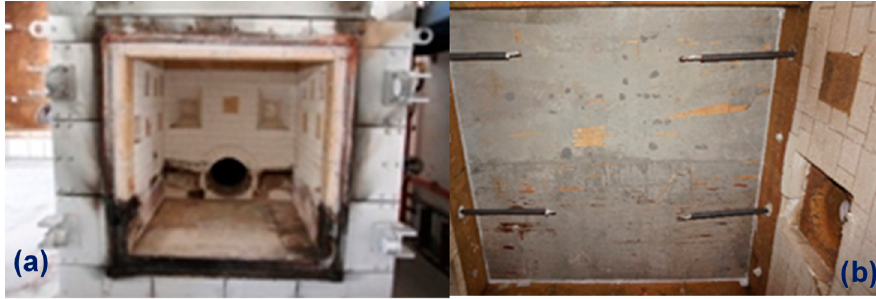
Figure 4. Fresh concrete test results ( a ) slump-flow ( b ) V-funnel ( c ) L-box.